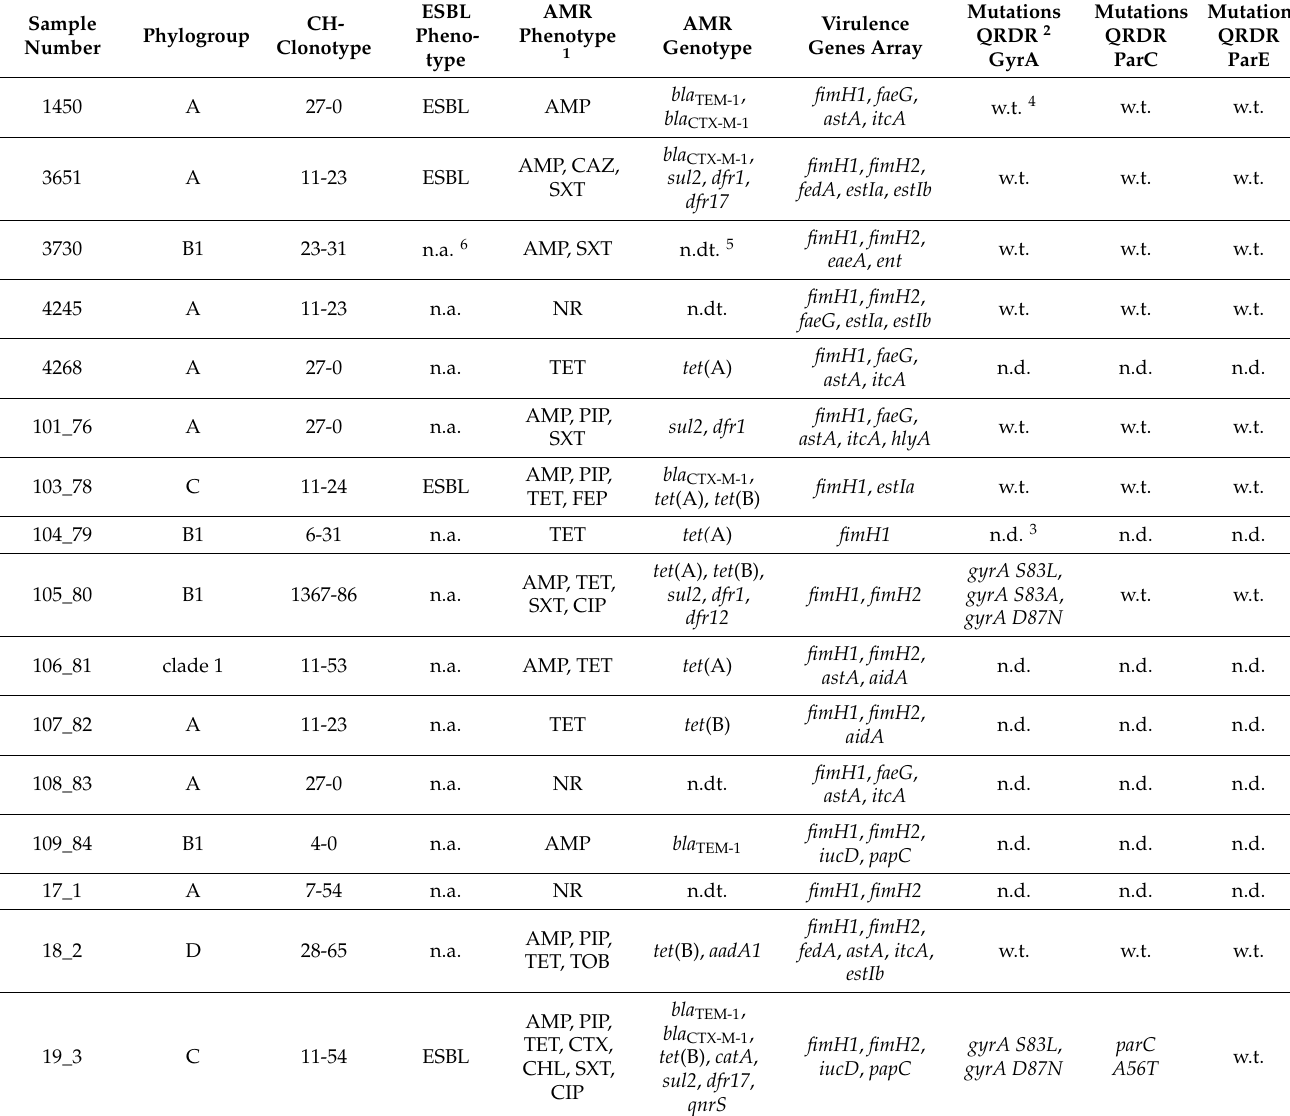
Table 1. Pheno- and genotypic characterization of E. coli isolated from porcine